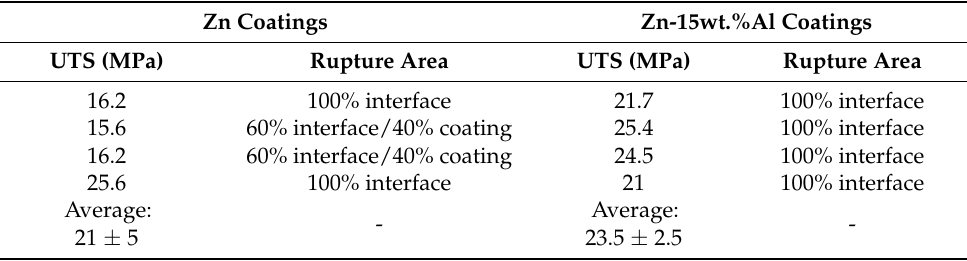
Table 2. Pull-off experiments: results obtained for four Zn and four Zn-15wt.%Al-coated steel P285NH samples. UTS = ultimate tensile